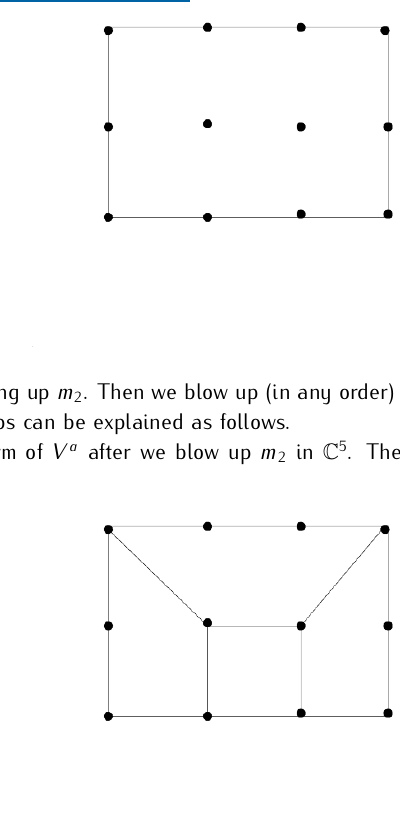
Figure 2. The Newton polytope of V b